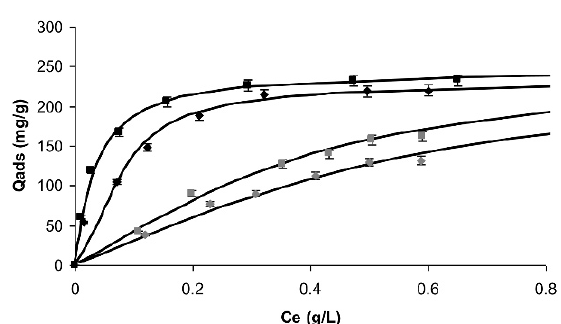
Figure 6. Adsorption isotherms obtained at pH 4 on ( (cid:4) ) HFAU zeolite and ( (cid:7) ) HBEA zeolite for (black) nitrophenol and (grey) chlorophenol. IsothermsdescribedbyFowler-Guggenheim model.